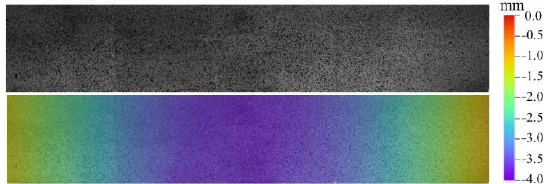
Figure 11. Full-surface speckle pattern and contour of the beam surface.